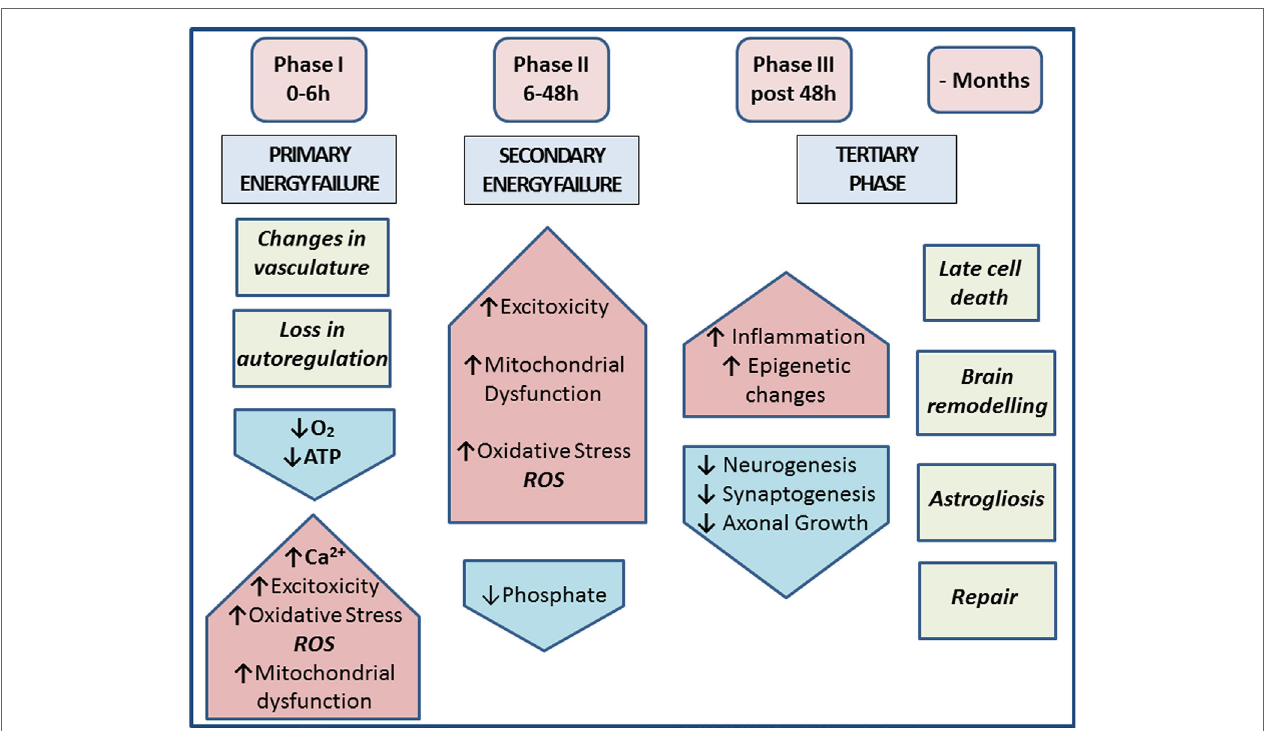
FiGURe 1 | Phases of injury post-Hie . Phase I at 0–6 h post-insult includes vasculature changes and primary energy failure. This results in loss of autoregulation and severe lowering of the systemic arterial blood pressure. This causes decrease in oxygen, depletion of ATP, increased excitotoxicity, raised intracellular calcium, oxidative stress (ROS), and mitochondrial dysfunction. Phase II at 6–48 h post-insult and secondary energy failure lead to continued excitotoxicity, mitochondrial dysfunction, and oxidative stress; reduced phosphate levels. Phase III post 48 h shows injury to microglia, neurons, and astrocytes and also leads to continuous release of cytokines and other detrimental factors causing chronic inflammation, which in turn lead to epigenetic changes, as well as impairment of synaptogenesis, axonal growth, and neurogenesis. The tertiary phase continues months after injury involving late cell death, brain remodeling, and astrogliosis [based on Ref. (7,